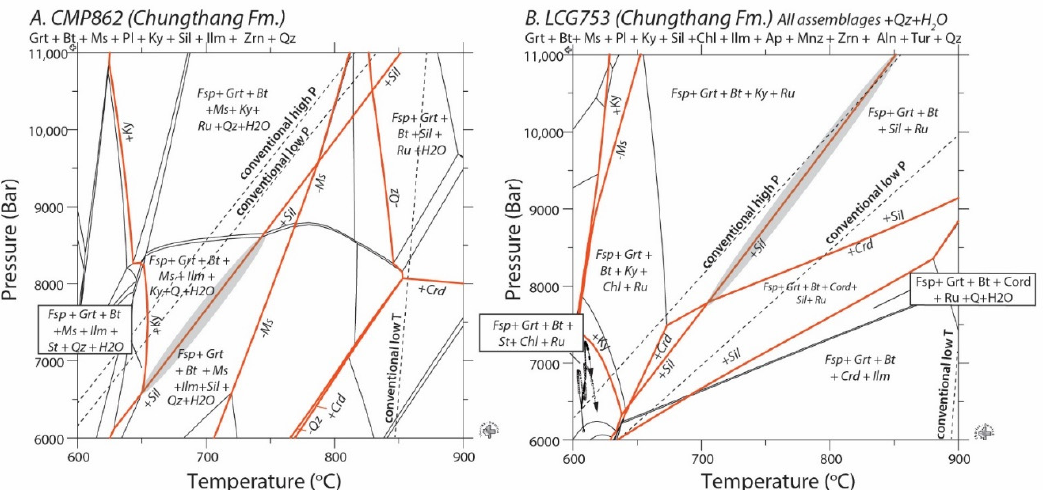
Figure 11. Isochemical phase diagrams Chungthang Formation samples ( A ) CMP862 and ( B ) LCG753. In each diagram the appearance of key index minerals are shown by labeled orange lines. The conventional P-T lines of equilibria are shown as dashed lines. These would predict very high P-T conditions outside the boundary of the diagrams. The high-resolution P-T paths are shown in panel ( B ). The grey area in CMP862 is consistent with the mineral assemblage observed in the sample.